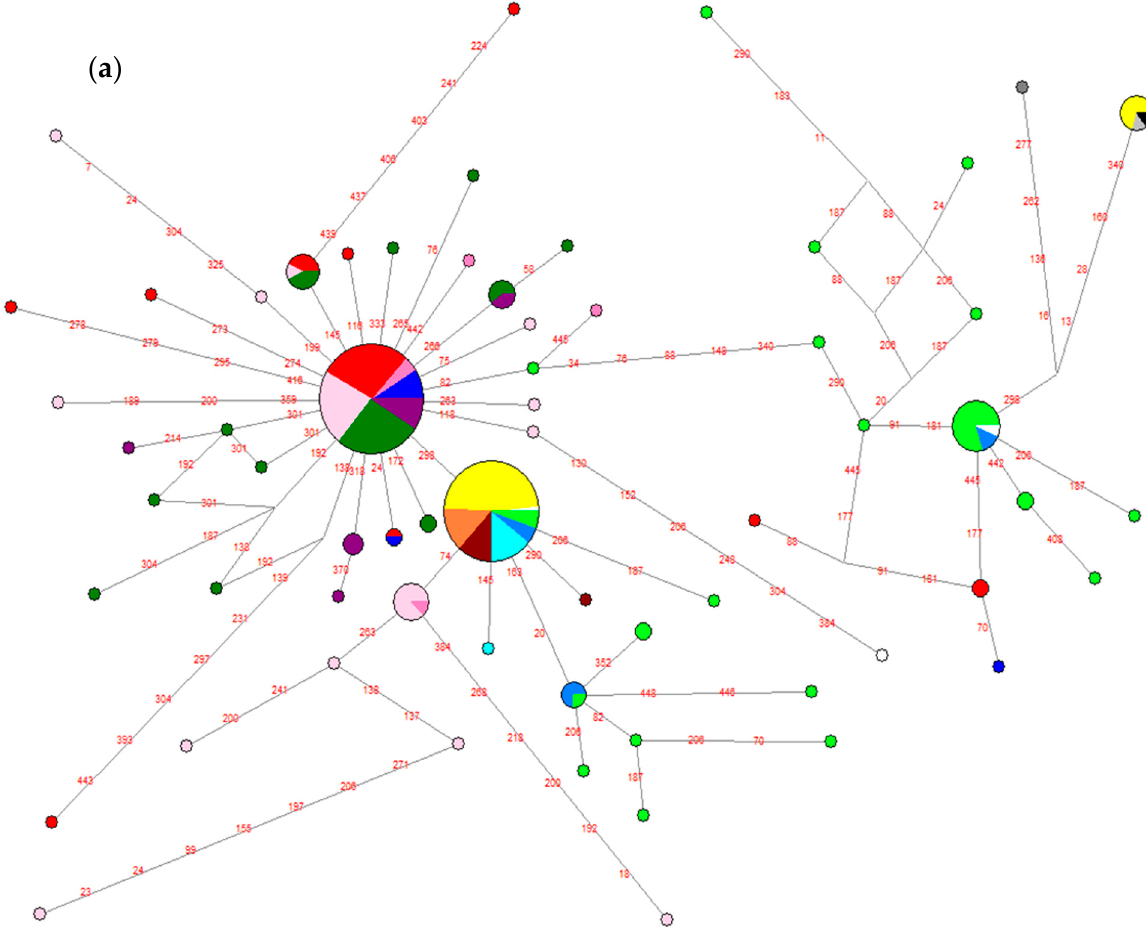
du Figure 3. ( a , top ) Haplotype network displaying the diversity and evolution of BFDV Rep haplotypes in Mauritius para- keet hosts. The size of each circle is proportional to the number of individuals sharing that viral haplotype and the length of the lines between circles are proportional to the number of base pair changes between each haplotype. ( b , bottom ) Number of individuals screened (dashed bars), viral prevalence (solid bars), and number of haplotypes (grey line) detected from 1993 to 2017. Color codes in 3a refer to the sampling year shown in 3b. The screening dataset from 2005 to 2017 comprises a systematic sampling of fledglings. N u m b e r o f i n d i v i